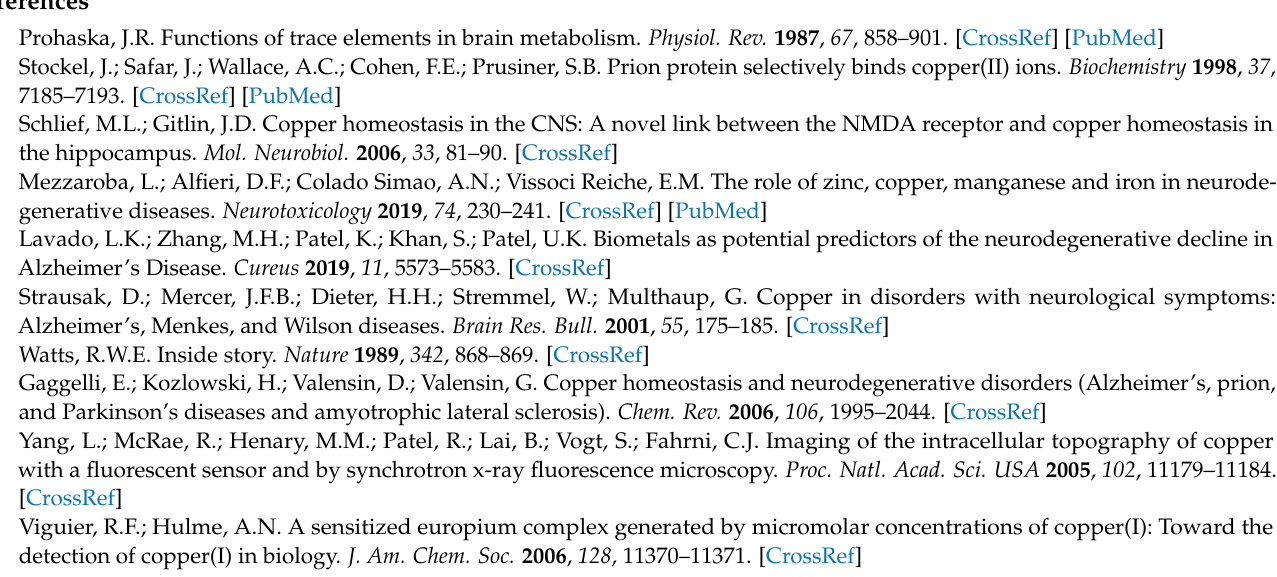
J7, Table S1: Cytotoxicity of probes J6 and J7 in ECV304 at 24